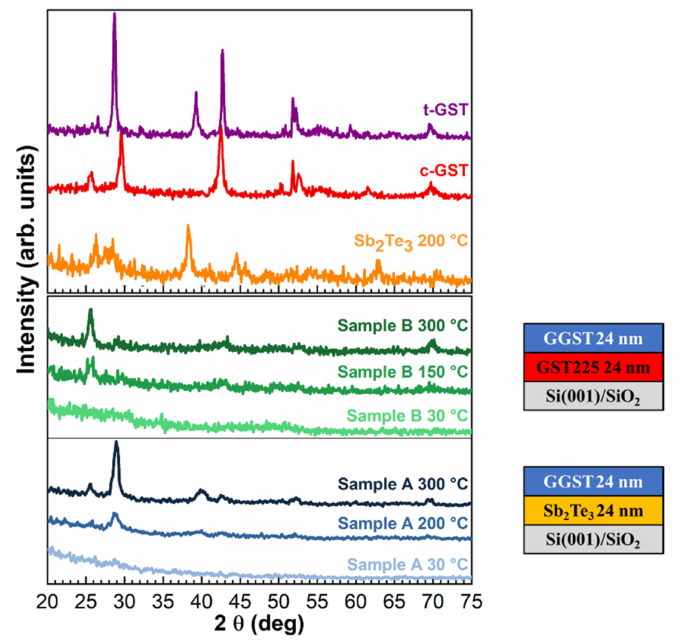
Figure 6. ω -2 θ XRD curves as a function of the annealing temperature for sample A and B. Single layer (Sb 2 Te 3 , c-GST225, and t-GST225 used as reference for cubic and trigonal polycrystalline GST) XRD scans are shown as